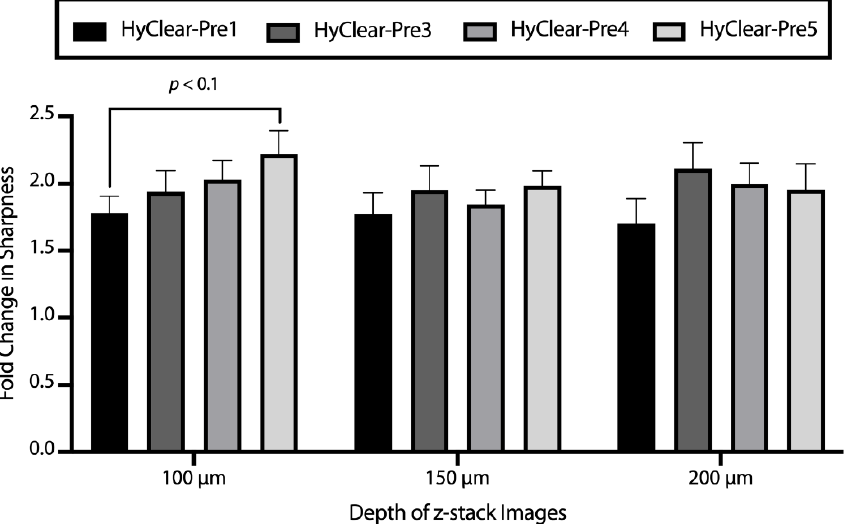
Figure 7. The average fold increase in image sharpness after clearing in different imaging depths using various HyClear formulations. All variations of HyClear improve the sharpness by more than ~1.6 times. The addition of urea suggests improving the sharpness, although the significance cannot be established in all cases. The p ‐ values are calculated using a heteroscedastic two ‐ tailed t ‐ test. The error bars represent the standard error of the mean of five to six replicates.